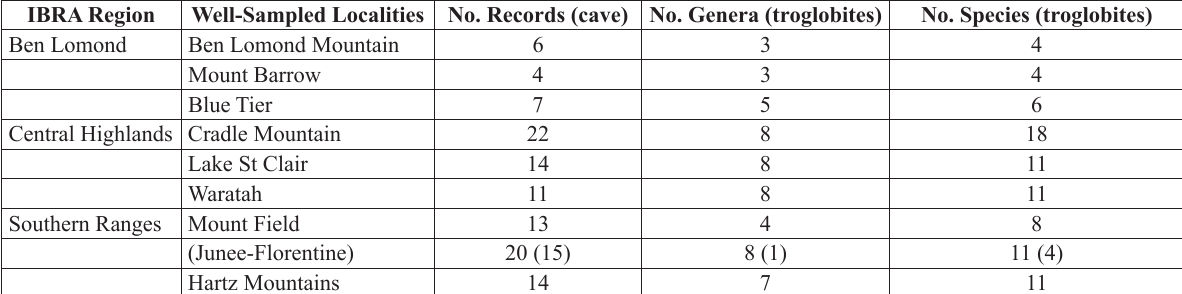
Table 3 - Recorded diversity at selected localities subjected to repeated survey effort. Karst localities and cave records / troglobitic taxa shown in brackets “(